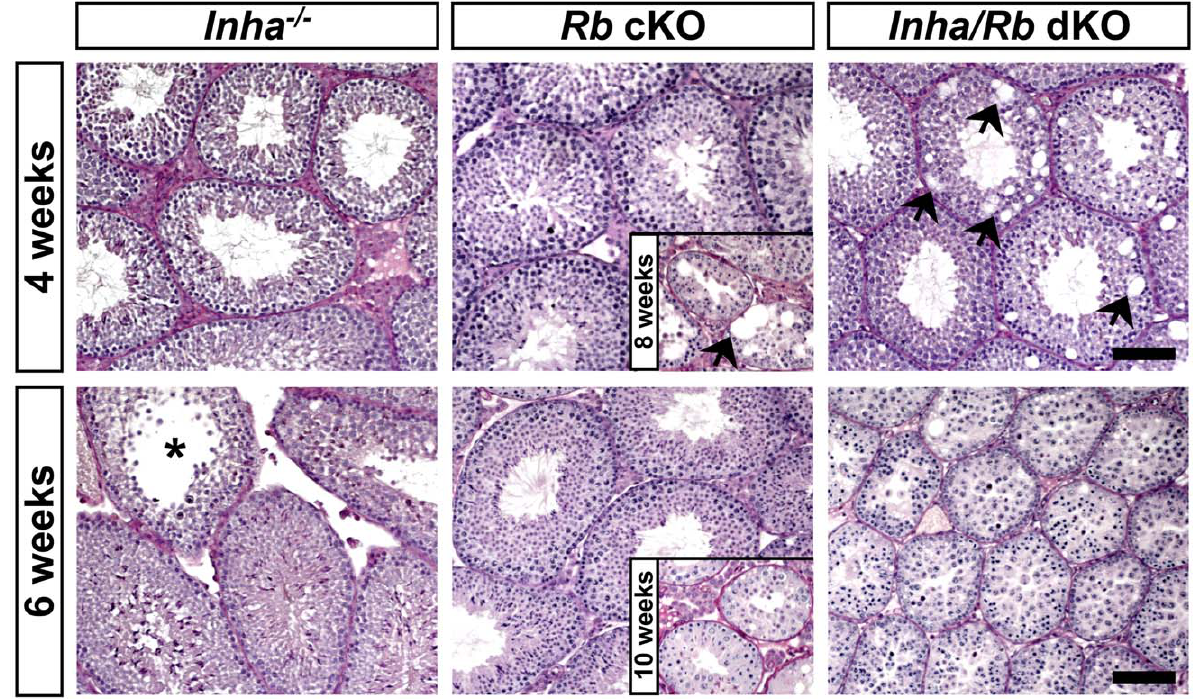
Figure 4. Seminiferous tubules in Inha/Rb dKO mice show an acceleration of the Sertoli cell dysfunction seen in Rb cKO mice. Histological examination of the seminiferous epithelium of 4 week-old Inha 2 / 2 ( top left ), Rb cKO ( top middle ), and Inha/Rb dKO ( top right ) mice reveals the presence of normally maturing germ cells in all genotypes, but 4 week-old Inha/Rb dKO Sertoli cells contain vacuoles ( top right , arrows), a sign of Sertoli cell dysfunction that is seen in Rb cKO mice at older ages ( top middle, inset ). Areas of 6 week-old Inha 2 / 2 and Rb cKO testes that contain seminiferous tubules exhibit all stages of spermatogenesis ( bottom left and middle, respectively ), although some Inha 2 / 2 tubules are showing signs of dysfunction, such as loss of elongating spermatids ( bottom left , asterisk). In contrast, areas of 6 week-old Inha/Rb dKO testes that contain seminiferous tubules show signs of extreme Sertoli cell dysfunction, such as loss of seminiferous tubular lumen, decreased tubular width, and loss of maturing germ cells ( bottom right ), that resemble advanced stages of infertility progression in Rb cKO mice ( bottom middle, inset ). All panels are captured at 100 6 magnification; scale bars, 100 m m.